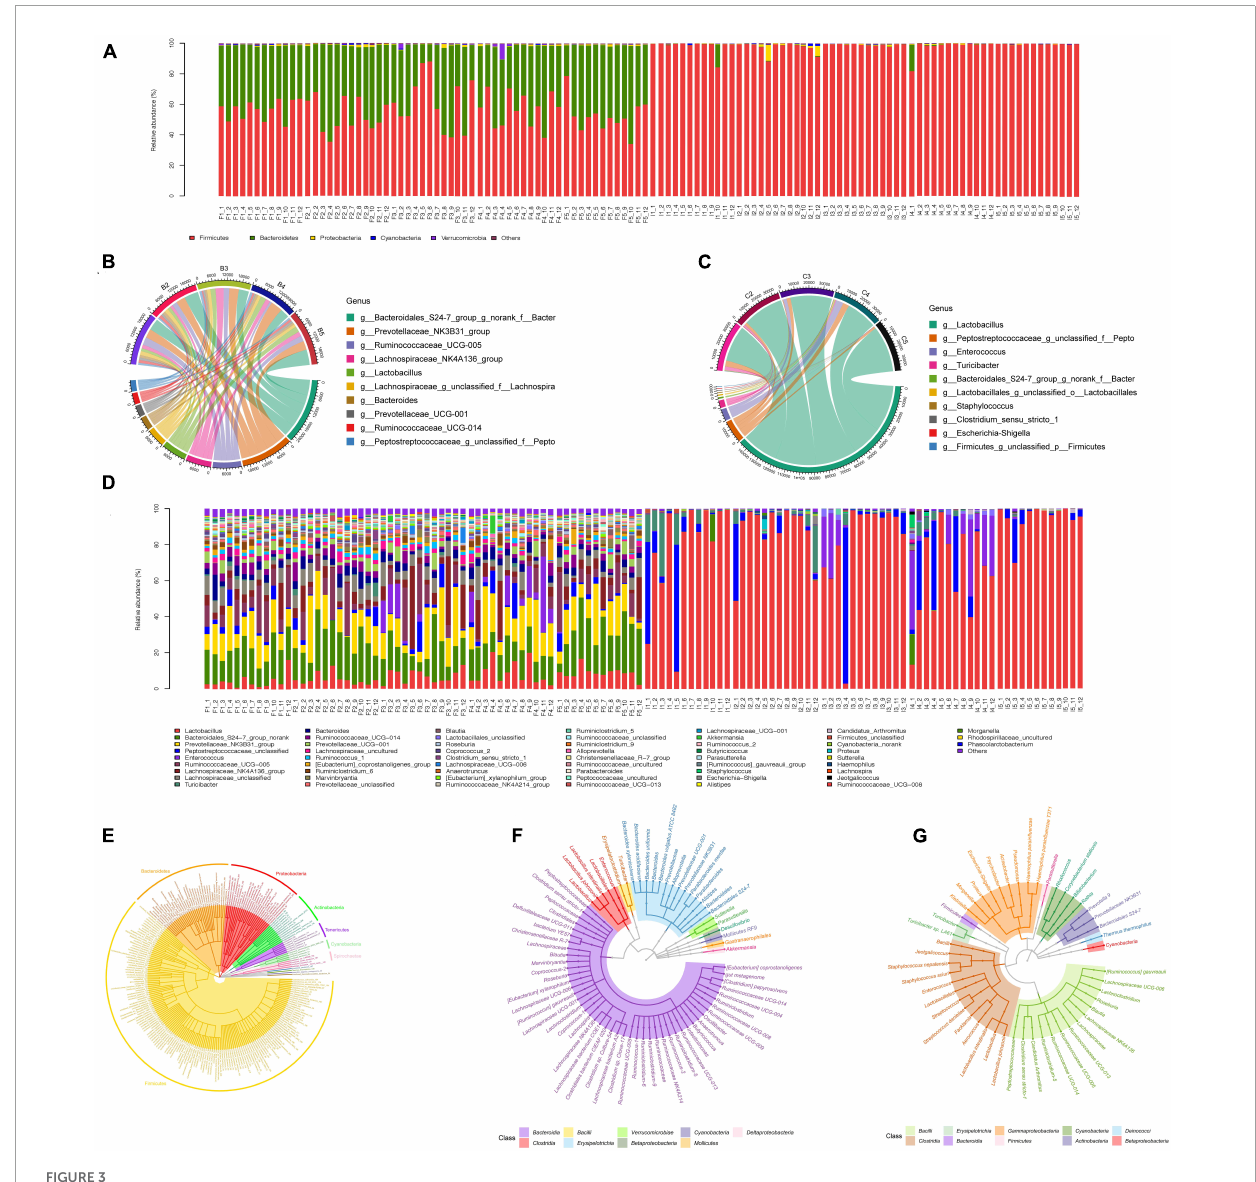
FIGURE3 Gut microbiota composition analysis of feces and ileum samples. (A) Community bar plot analysis at the phylum level for all samples. F represents feces samples and I represents ileum samples. (B) Circos plot of the abundance of top ten dominant genus in feces. (C) Circos plot of the abundance of top ten dominant genus in ileum. (D) Community bar plot analysis at the genus level for all samples. F represents feces samples and I represents ileum samples. (E) Phylogenetic tree of the diversity of gut microbiota in both feces and ileum groups at the species level. (F) Phylogenetic tree of the diversity of gut microbiota in feces samples at the species level. (G) Phylogenetic tree of the diversity of gut microbiota in ileum samples at the species